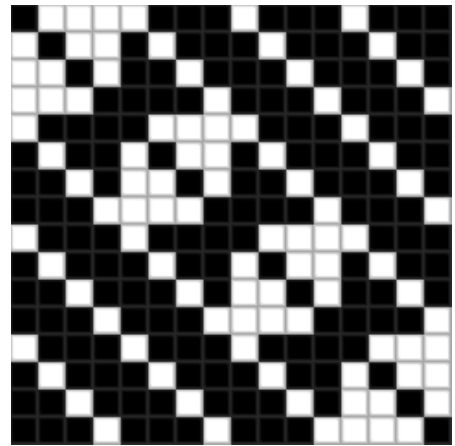
Figure 2: A regular Hadamard and 2-variable orthogonal matrix for order 16